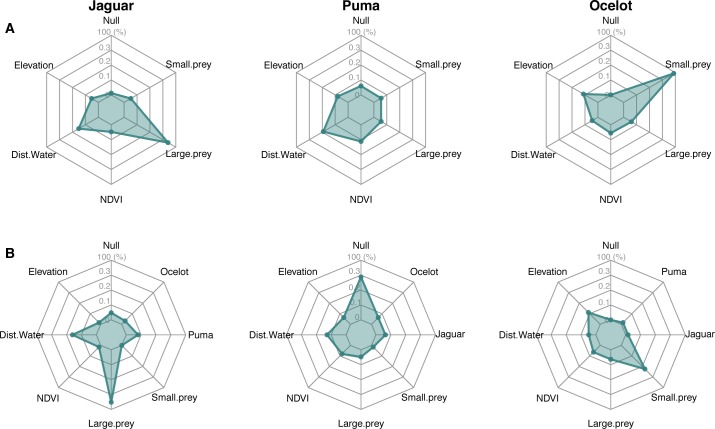
Relative importance of environmental and interaction covariates on the habitat use of three Neotropical forest cats.Row A–Sum of models weights (AICwt/QAICwt) of occupancy models to assess habitat factors; row B–Sum of models weights (AICwt/QAICwt) of occupancy models to assess both habitat factors and species interactions.